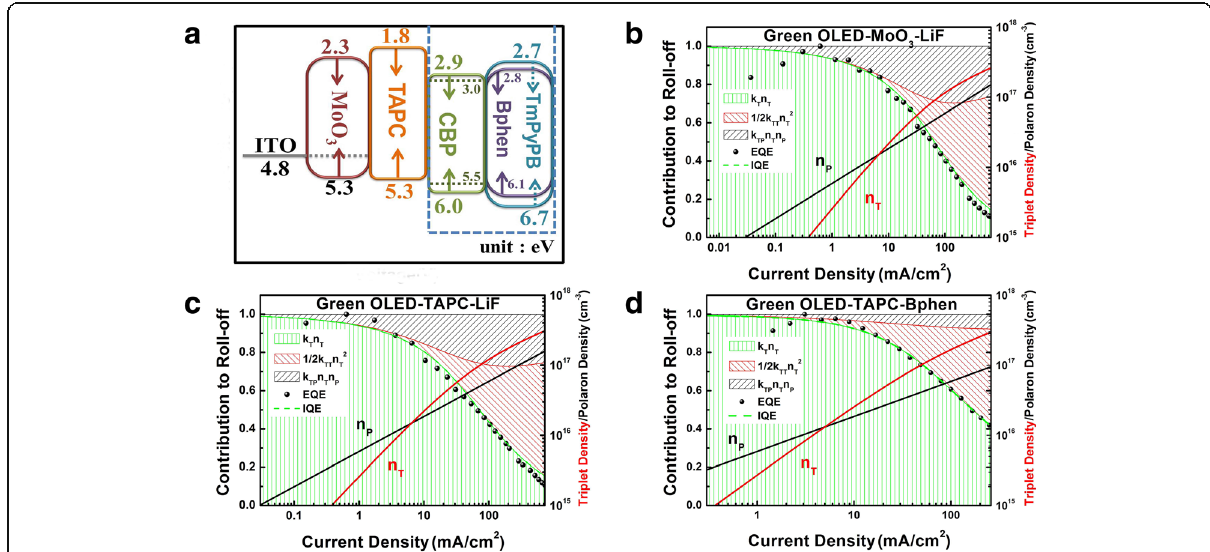
Fig. 4 a Schematic energy-level diagrams of the three devices. Simulated internal quantum efficiency (IQE) (solid green or red line) and external quantum efficiency (EQE) (scattered point) act as a function of the current density. Triplet and polaron densities (red and black lines) are calculated according to Eqs. (4) – (7). Hatched areas indicate the relative contribution of TPA and TTA as well as of the emission to the overall exciton decay. b – d correspond to device 1, device 2, and device 3, respectively